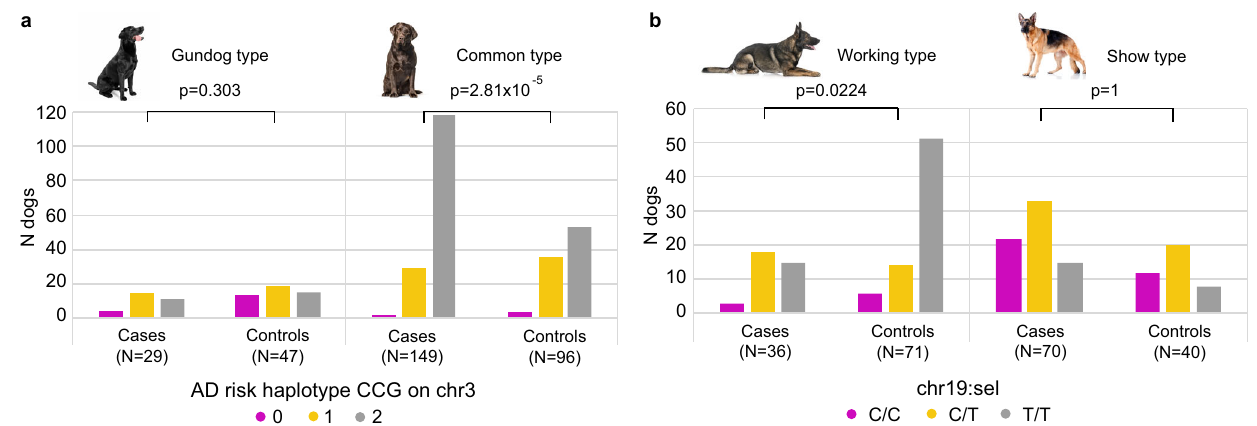
Fig. 6 Allele frequency differences between breed types in both Labrador retrievers and German shepherds. In LR, the number of cases with CCG (risk haplotype on chromosome 3) was signi fi cantly higher compared to controls of the common type ( χ 2 = 17.5, p = 2.81 × 10 − 5 ) whereas there was no signi fi cant difference in the gundog type ( χ 2 = 1.06, p = 0.303; homozygous = 2, heterozygous = 1, or homozygous non-risk = 0; a ). In GSD, a homozygous T/T genotype at the top selection variant, chr19:sel, was more frequent among controls of working type ( χ 2 = 5.21, p = 0.0224) but in the show type there was no difference ( χ 2 = 0, p = 1; b ). Dogs were split into subpopulations by a cutoff at PC1 of − 0.05 in LR and 0 in GSD. Pearson ’ s Chi- squared test with Yates ’ continuity correction of allele frequencies between cases and controls within each breed type was used. Two GSD controls from the working subpopulation did not have a genotype call and were excluded from the plot and this calculation (Supplementary Data 9). Table 3 AD-candidate genes in BayesR and XP-EHH regions with implicated functions in epidermis and/or immunity.